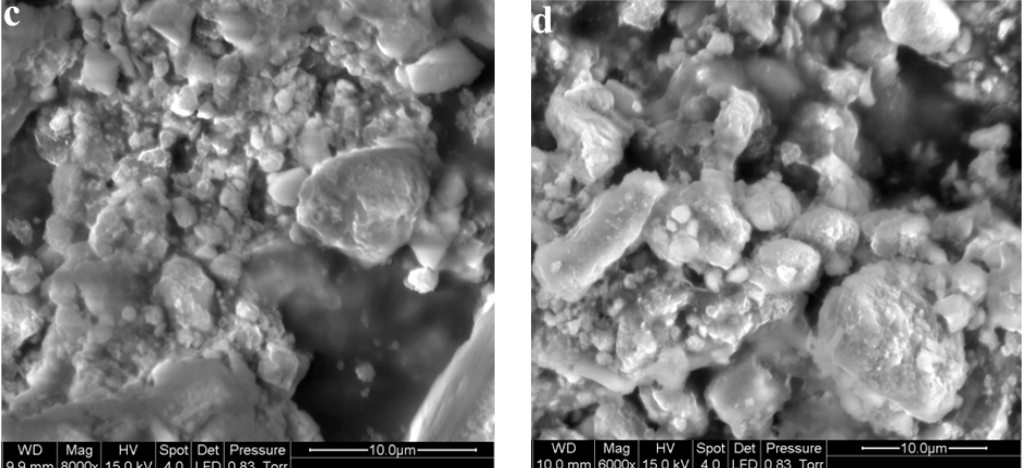
Figure 4. SEM images of solid stone coal. ( a ) Initial stone coal sample; ( b ) stone coal in Bioreactor after six cycle operation; ( c ) stone coal in Control 1 after six cycle operation; ( d ) stone coal in Control 2 after six cycle operation.